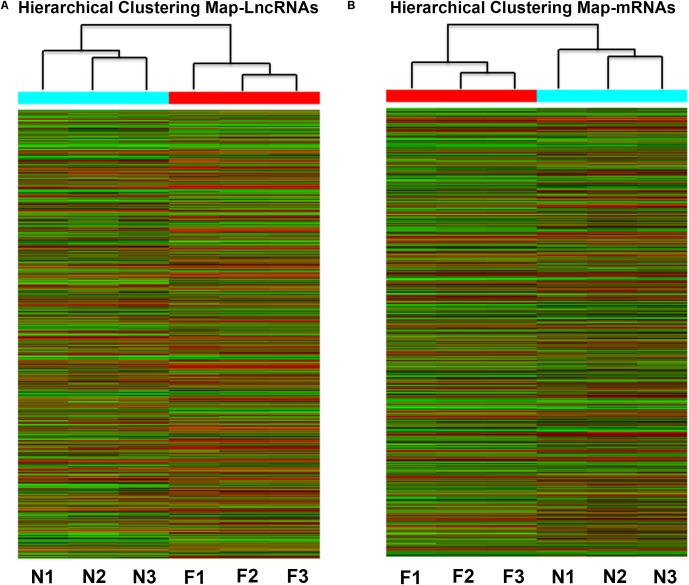
Heat map of the differentially expressed lncRNAs (A) and coding genes (B) in NAFLD mice and control mice. Each row represents the relative expression level of a single lncRNA or mRNA, and each column represents a single sample. High relative expression is indicated by red color and low relative expression is indicated by green color. F1-3: NAFLD group. N1-3: control group.